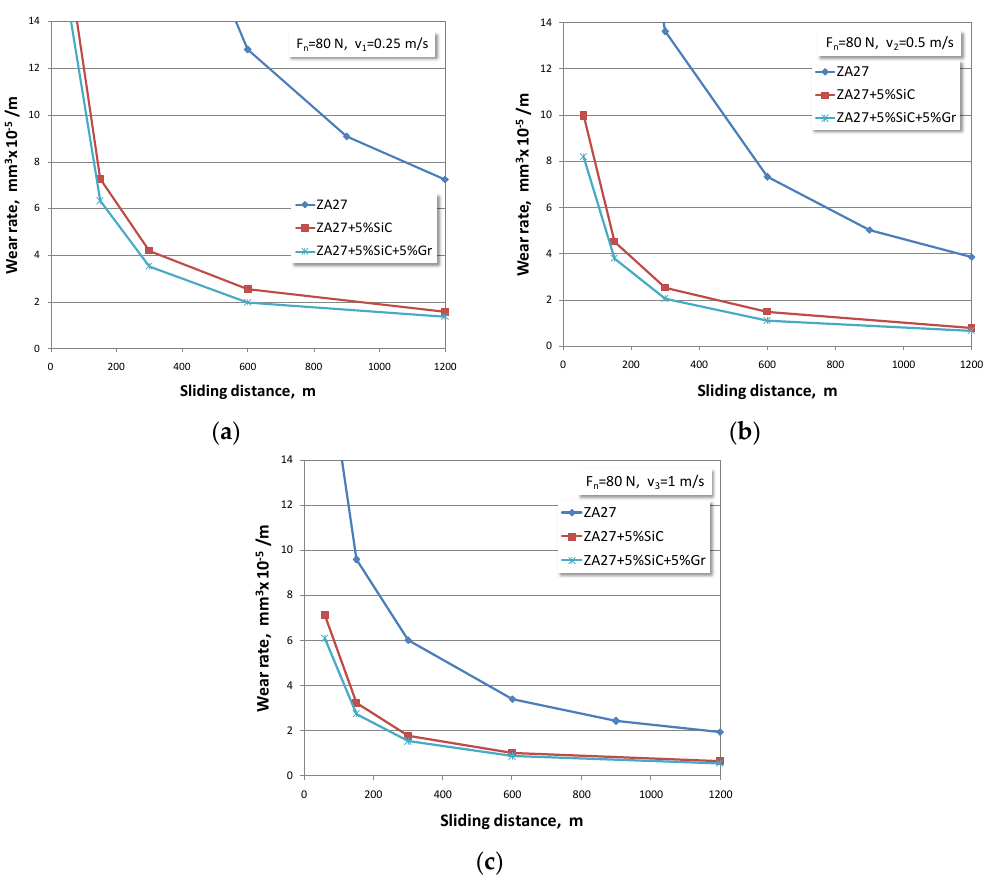
Figure 4. Wear rates for normal load of 80 N and sliding speeds of: ( a ) v = 0.25m/s; ( b ) v = 0.5m/s; ( c ) v = 1 m/s.